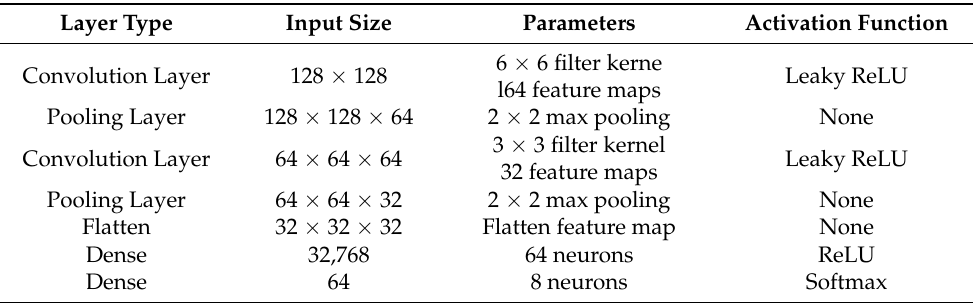
Table 3. Structure of baseline classifier.